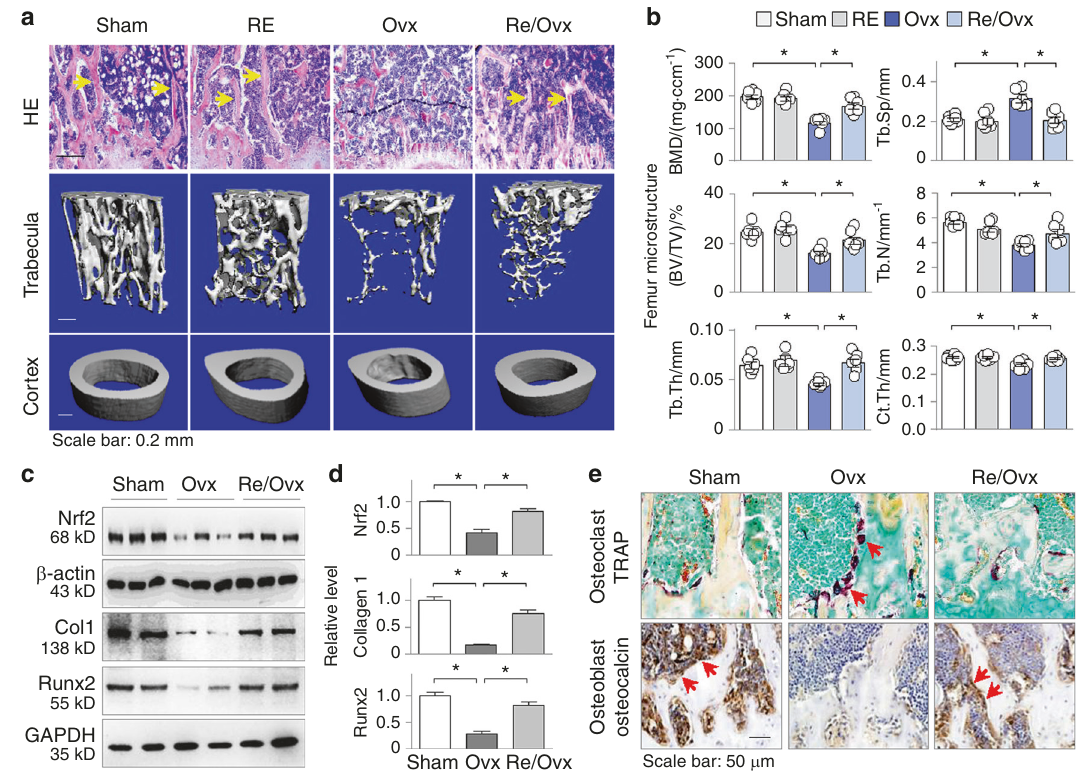
Fig. 4 Running exercise derepresses Nrf2 and protects mice from osteoporosis. Female ICR mice were divided into the sham, RE, Ovx and RE/ Ovx groups as described in the methods (6 mice in each group). a Representative photomicrographs of H&E-stained (the upper panel), micro- CT-scanned distal femoral trabecula (the middle panel) and cortex (the lower panel). b Three-dimensional microstructural analyses of distal femurs in Fig. 4a. Bone mineral density (BMD, mg·ccm − 1 ), the ratio of bone volume to tissue volume (BV/TV), trabecular number (Tb.N), trabecular thickness (Tb.Th), trabecular separation (Tb.Sp) and cortical thickness (Ct.Th) were assessed. Data are presented as the mean ± SEM, * P < 0.05, two-way ANOVA. c Western blotting of Nrf2, collagen 1 (Col 1) and Runx2 from femur homogenates of the experimental mice. Two or three representative samples from each group are shown. d Quanti fi cation of Fig. 4c. Data are presented as the mean ± SEM of all experimental mice. * P < 0.05, one-way ANOVA. e Representative microphotographs of immunohistochemistry staining for TRAP and osteocalcin from mouse femur sections. The positively stained cells are indicated by